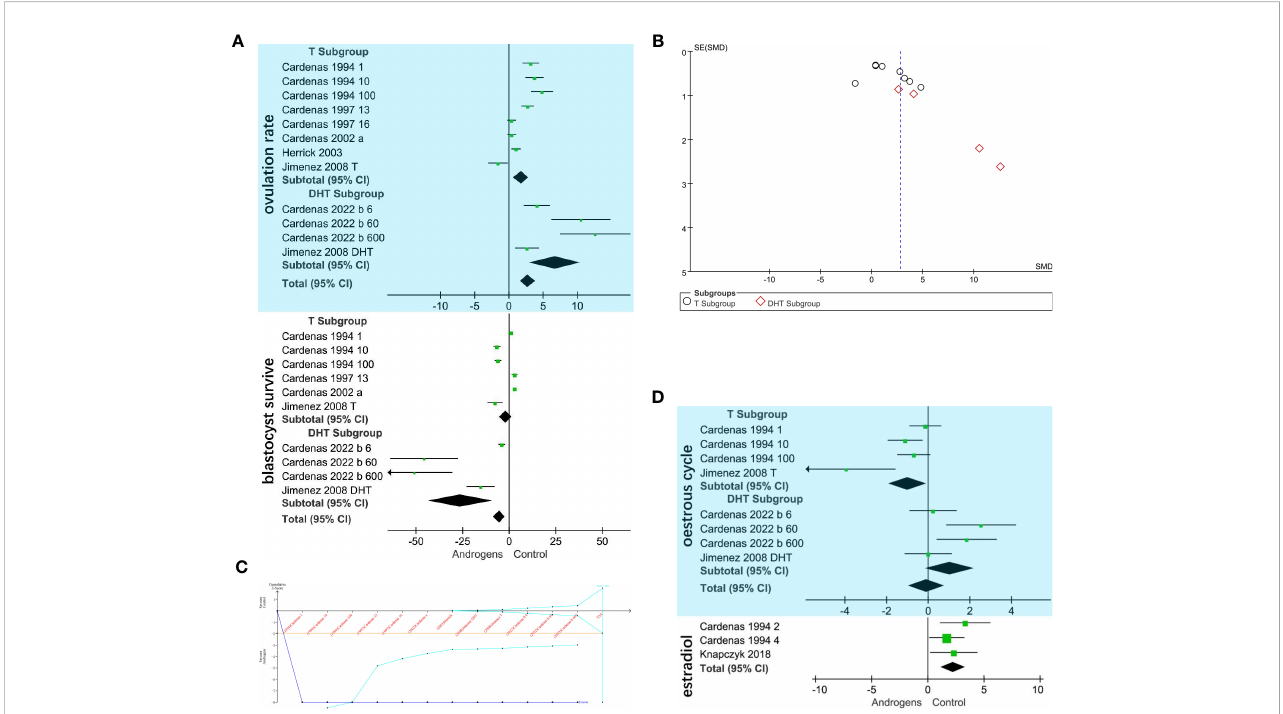
FIGURE 2 In vivo androgen effects on sow ovary. (A) Forest plot of androgen effects on swine ovulation rate (blue) and blastocyst survival rate (white). Subgroup analysis was performed based on testosterone (T) and dihydrotestosterone (DHT). Injection of T or DHT into sows was positively related to ovulation rate. DHT was negatively correlated with blastocyst survival rate. (B) Funnel plot of androgen effects on the swine ovulation rate. The dotted vertical line is the estimated common effect. The points of the selected study representatives are concentrated at the top of the line, and there is no potential bias. (C) Trial Sequential Analysis Viewer (TSA) of androgen effects on the swine ovulation rate. The research results exceeded the conventional boundary (orange line) and monitoring boundary, indicating that the meta-analysis results are reliable. (D) Forest plot of androgen effects on the swine estrous cycle (blue) and estradiol (white). T is negatively correlated with the estrous